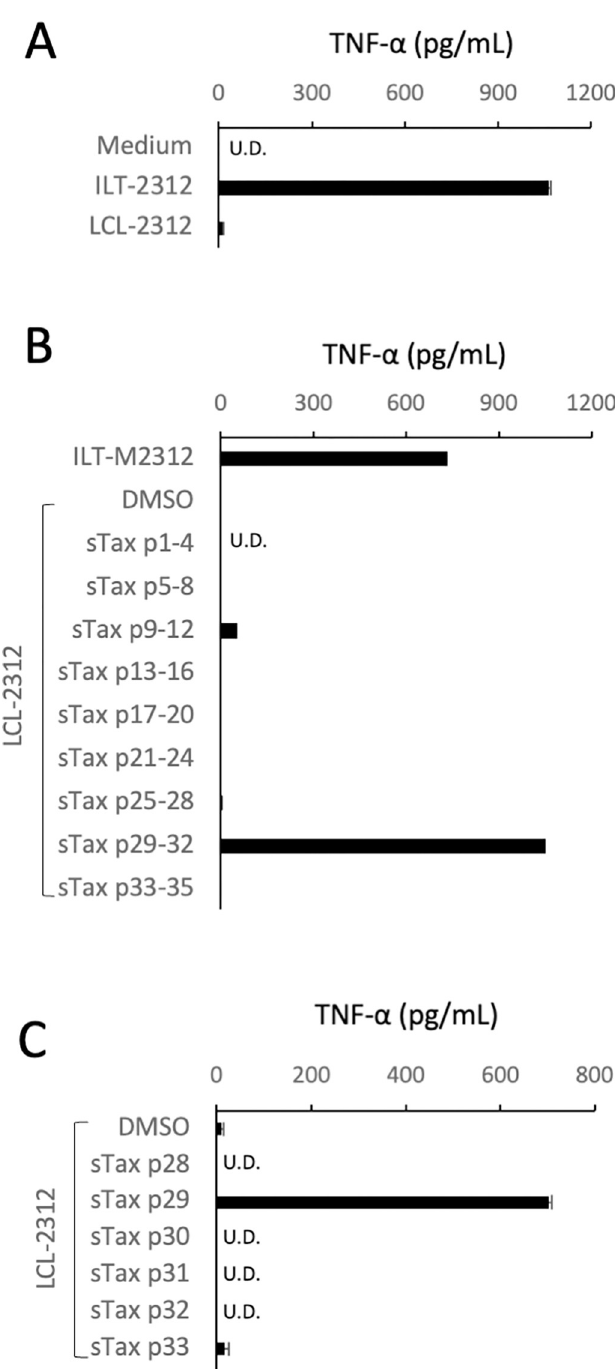
Fig 2. Recognition of a Tax epitope by STLV-1-specific CTLs from a Japanese monkey. STLV-1-specific CTLs induced from monkey #2312 (Tc-2312) by stimulation with formalin-fixed ILT-2312 in the presence of IL-2 were co- cultured overnight with autologous ILT or LCL cells ( A ) or autologous LCL cells that had been pulsed with 10 μ M of the pooled ( B ) or individual ( C ) STLV-1 Tax peptides, and then TNF- α levels in their supernatants were measured by ELISA. The amino acid sequences of the synthetic peptides used are listed in S2 Table. The values represent the mean and SD of duplicate samples in A and C , while the screening assay shown in B was performed with single samples.